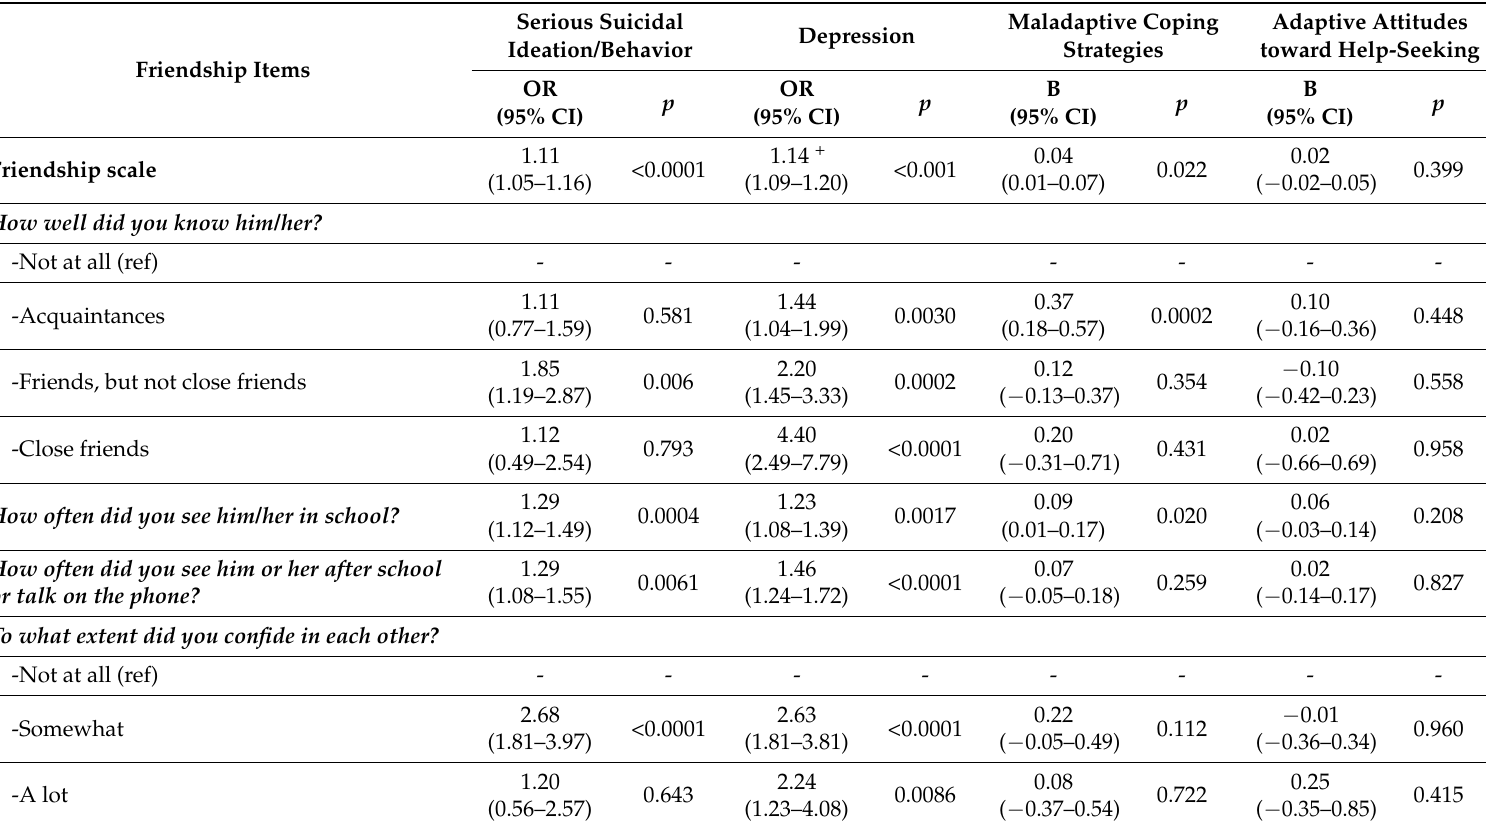
Table 4. Mixed effect regression analyses of serious suicidal ideation/behavior, depression, and attitudes about coping and help-seeking strategies by degree of friendship with suicide